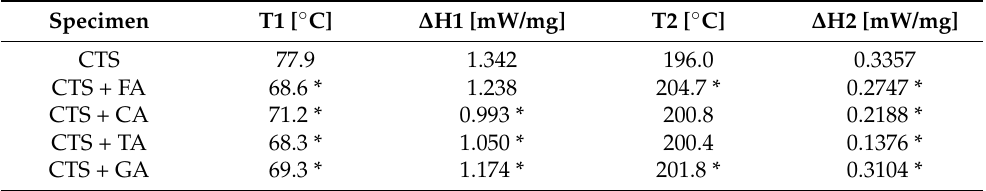
Table 2. The maximum temperature of the process (T) and enthalpy of the processes (ΔH) measured during the samples heating by differential scanning calorimetry (* significantly different from CTS — p < 0.05).